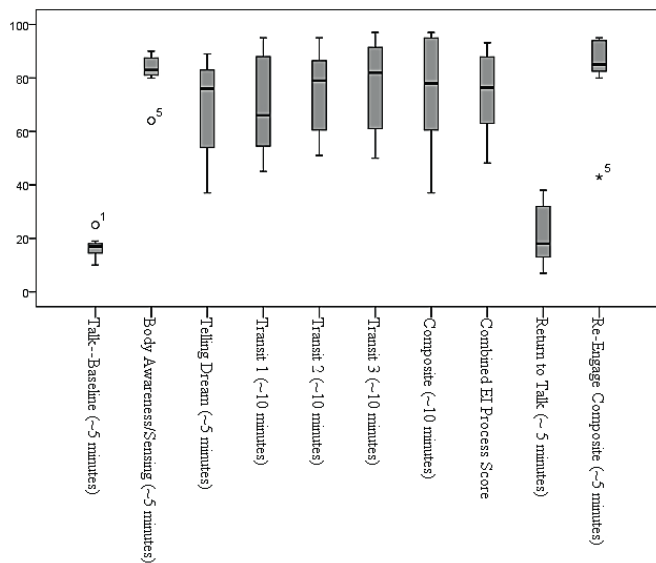
Figure 2. Awakened mind-percent compliance at demand level 5 – combined data (source: created by